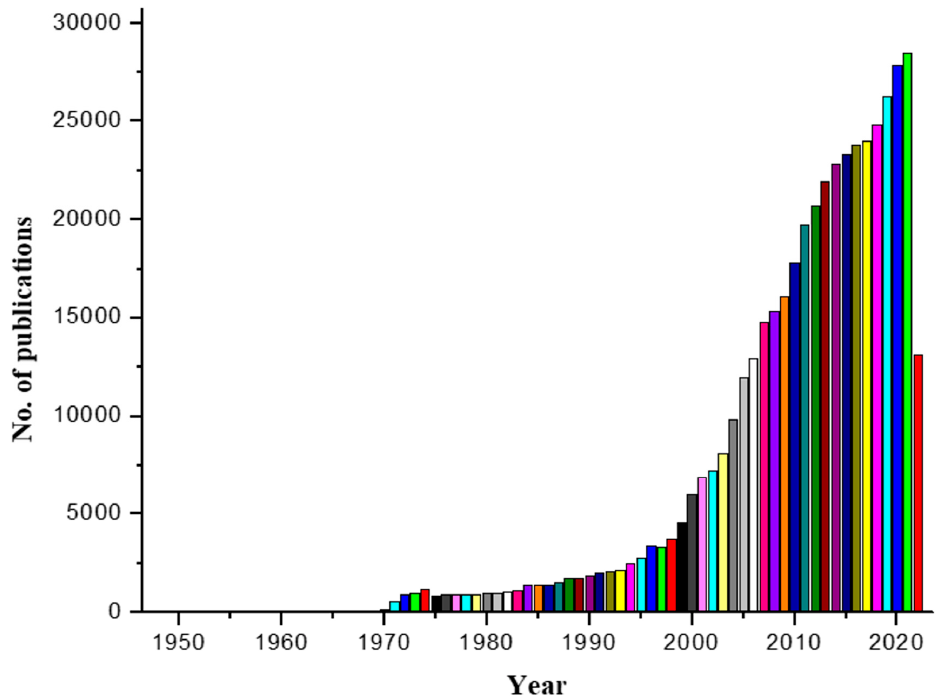
Figure 3. PubMed search on the term, “mass Figure 3 . PubMed search on the term, “mass spectrometry”.